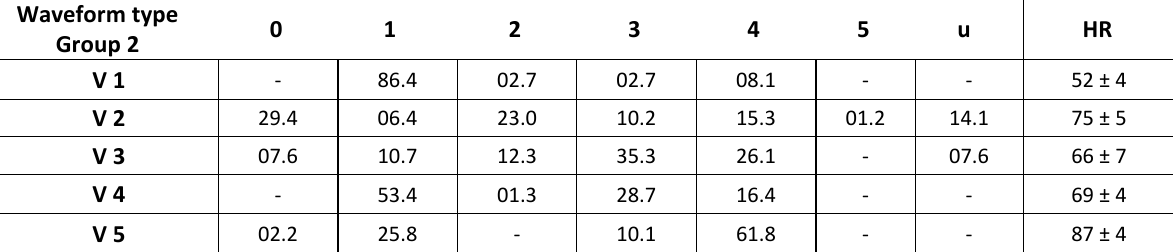
Table 4. Percentage of ABEXYOZ complexes contained in each recording per volunteer with the average heart-rate (mean ± SD) for group 2 Waveform type